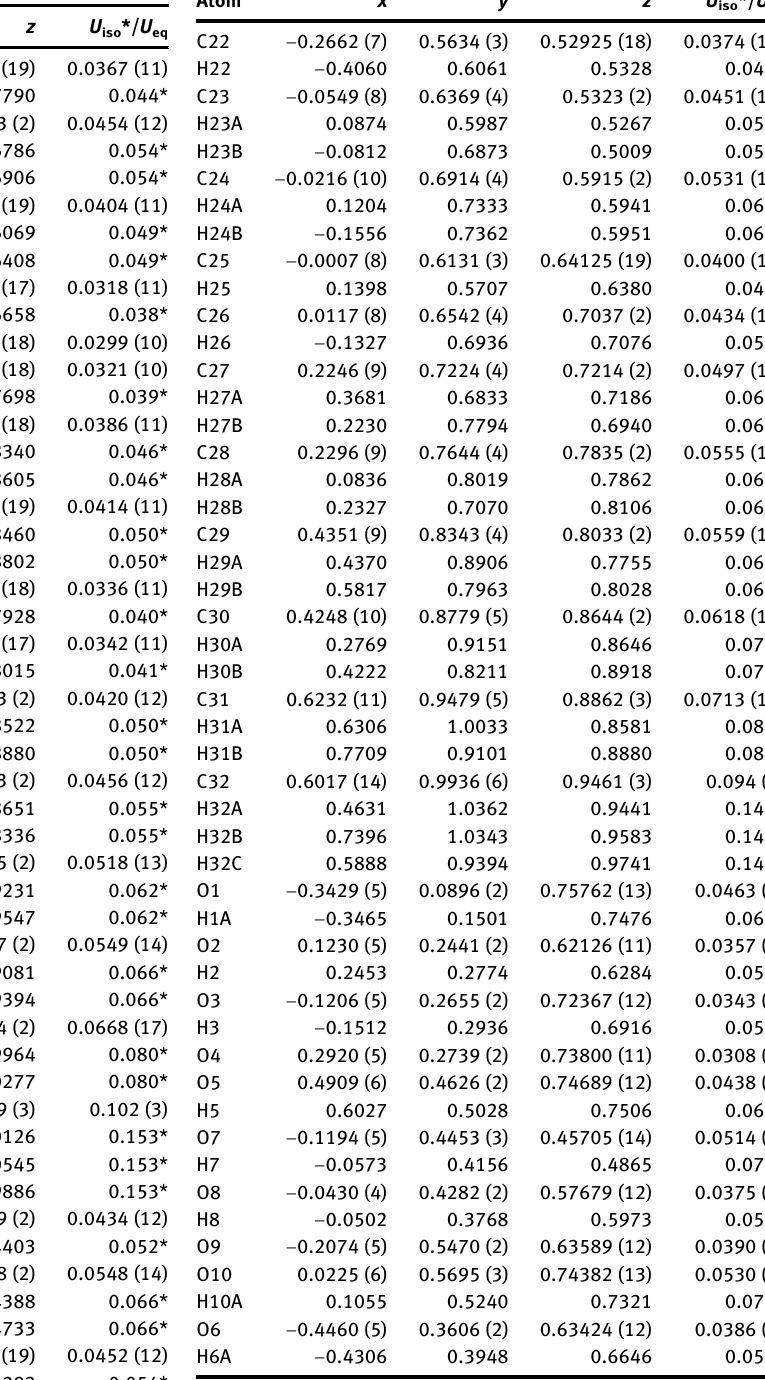
Table  : Fractional atomic coordinates and isotropic or equivalent isotropic displacement parameters (Å 